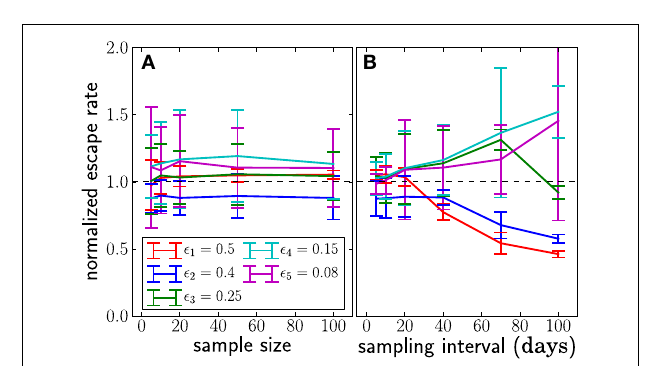
FIGURE 4 |Adding epitopes one by one is a feasible and reliable fitting strategy . Assuming we know the population was homogeneous at t = 0, there is only one free parameter for the first epitope, which is easily determined. For all subsequent epitopes, we need to determine the seed time τ j and the escape rate ε j . In (A) , the negative log posterior probability of these parameters is shown for each of the epitopes.The surface typically exhibits a single minimum. (B) shows the genotype frequencies